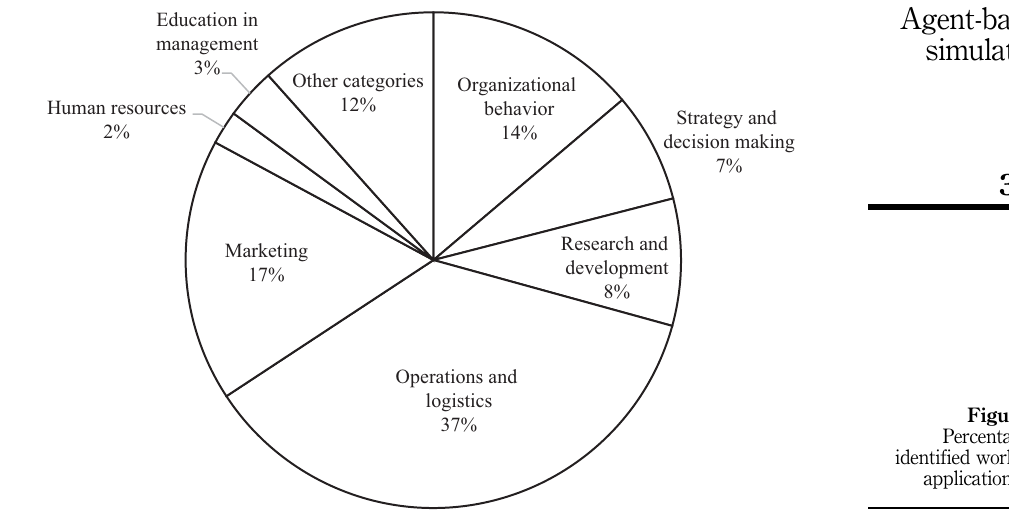
Figure 1. Percentage